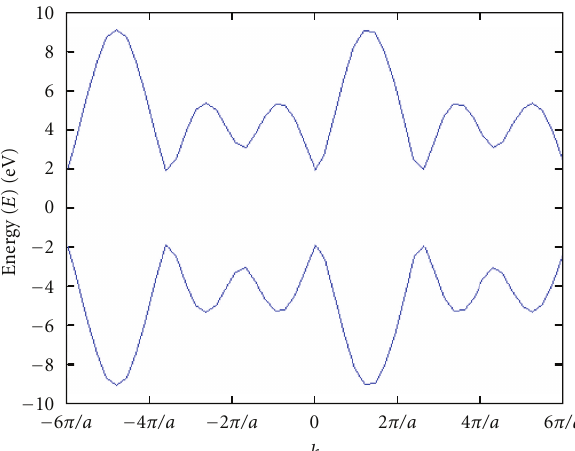
Figure 8: The energy dispersion variations of a chiral carbon nanotube, with m = 2 and n =